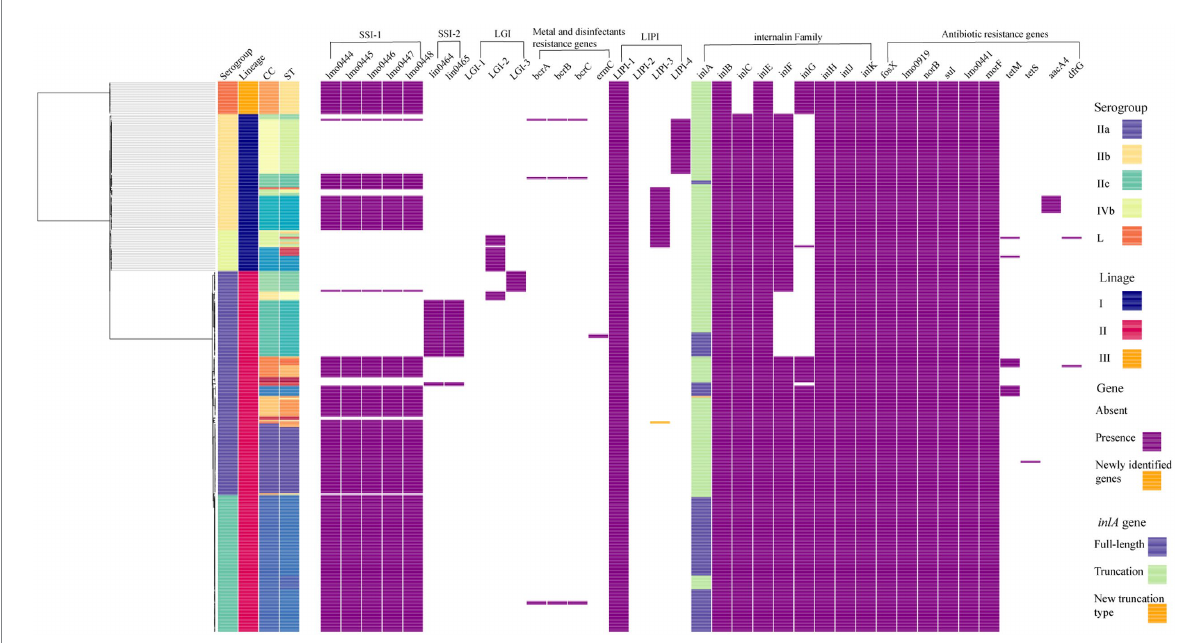
FIGURE 2 The core-SNP phylogenetic tree and genomic characterization of 322 foodborne L. monocytogenes isolates from China. Maximum likelihood phylogeny of 322 L. monocytogenes genomes based on 16,383 core-SNPs with EGD-e as the reference. Information of serogroup (dark purple boxes represent serogroup IIa, light orange boxes represent serogroup IIb, blue-green boxes represent serogroup IIc, light green boxes represent serogroup IVb, dark orange boxes represent serogroup L), lineage (dark blue boxes represent lineage I, rose red boxes represent lineage II, orange boxes represent lineage III), clonal complex and sequence type (they were clustered by different colors) are provided on the right. The distribution of different genes in L. monocytogenes was visualized using Phandango. The presence of a gene was marked with a purple box. The newly identified genes were marked with an orange box. For inlA gene, light green boxes represent full-length inlA gene, dark blue boxes represent truncated inlA